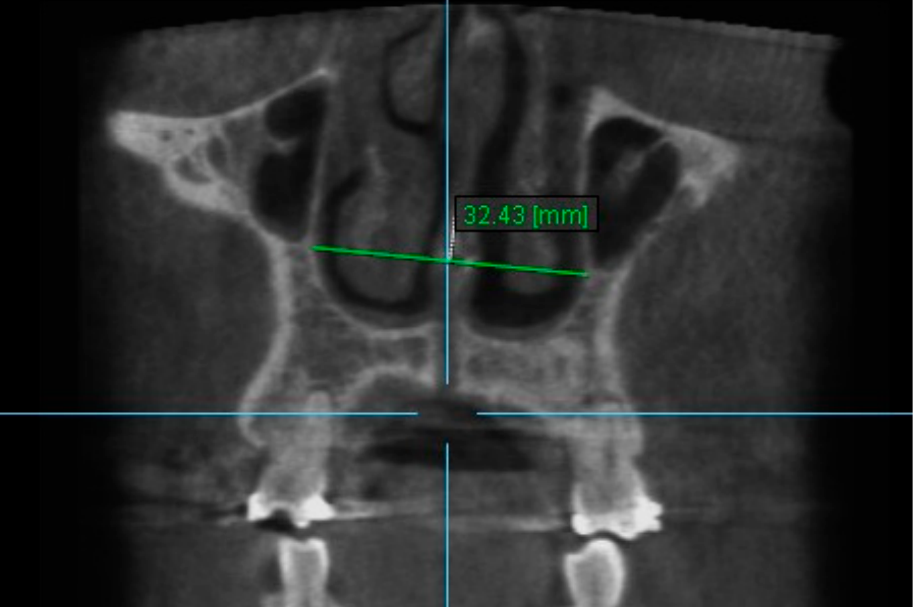
Figure 5. Nasal Width 3. 4. Nasal Width 4: The maximum distance between the inner right surface of nasal cavity and nasal septum on coronal slice through the center of mesial buccal root of the first premolar (Figure 6).